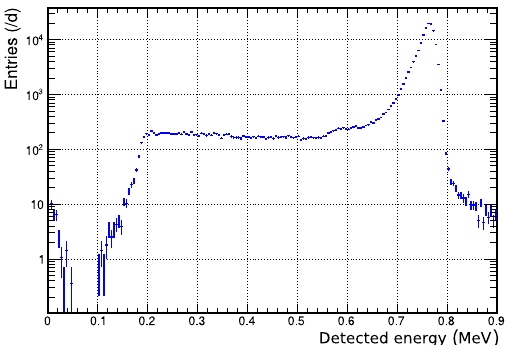
Fig. 2 Left: measured energy spectrum below 900 keV, covering the so-called thermal neutron capture energy region, taken at the ILL-H7 site without thermal neutron shielding surrounding the 3 He counter and while the nuclear reactor was in operation. Right: measured energy spectra up to 6 MeV obtained after 49 days of data taking at the Modane underground laboratory (blue) and during a few hours of neutron cal- ibration, using an AmBe source emitting 2 × 10 6 neutron per second